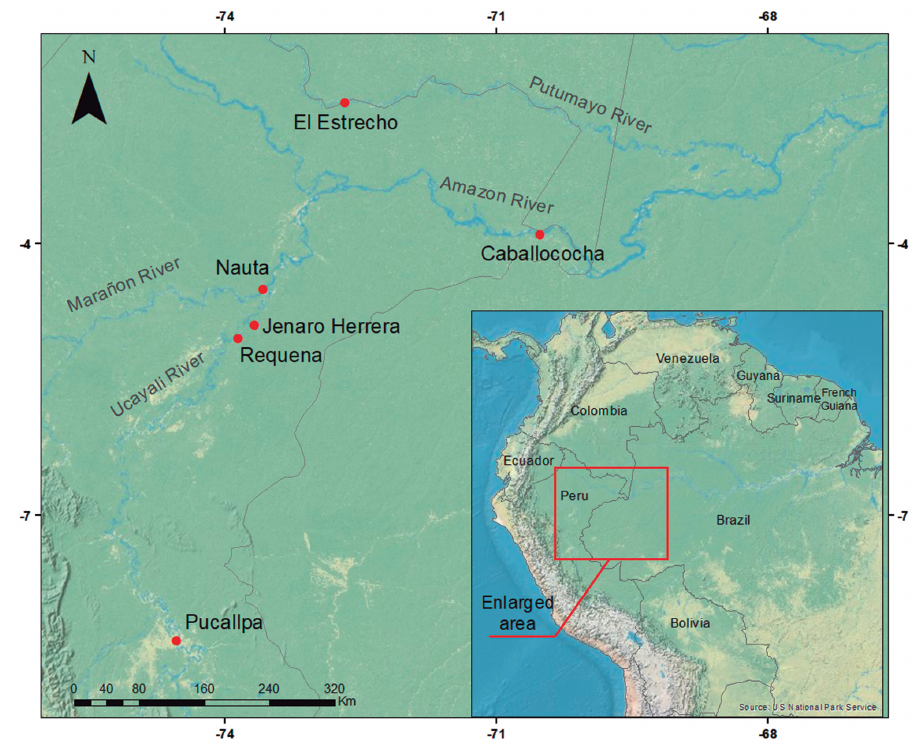
FIGURE 1 | Map of sampling sites of Pseudoplatystoma punctifer in the Peruvian Amazon River systems. Sampling sites are symbolized by red